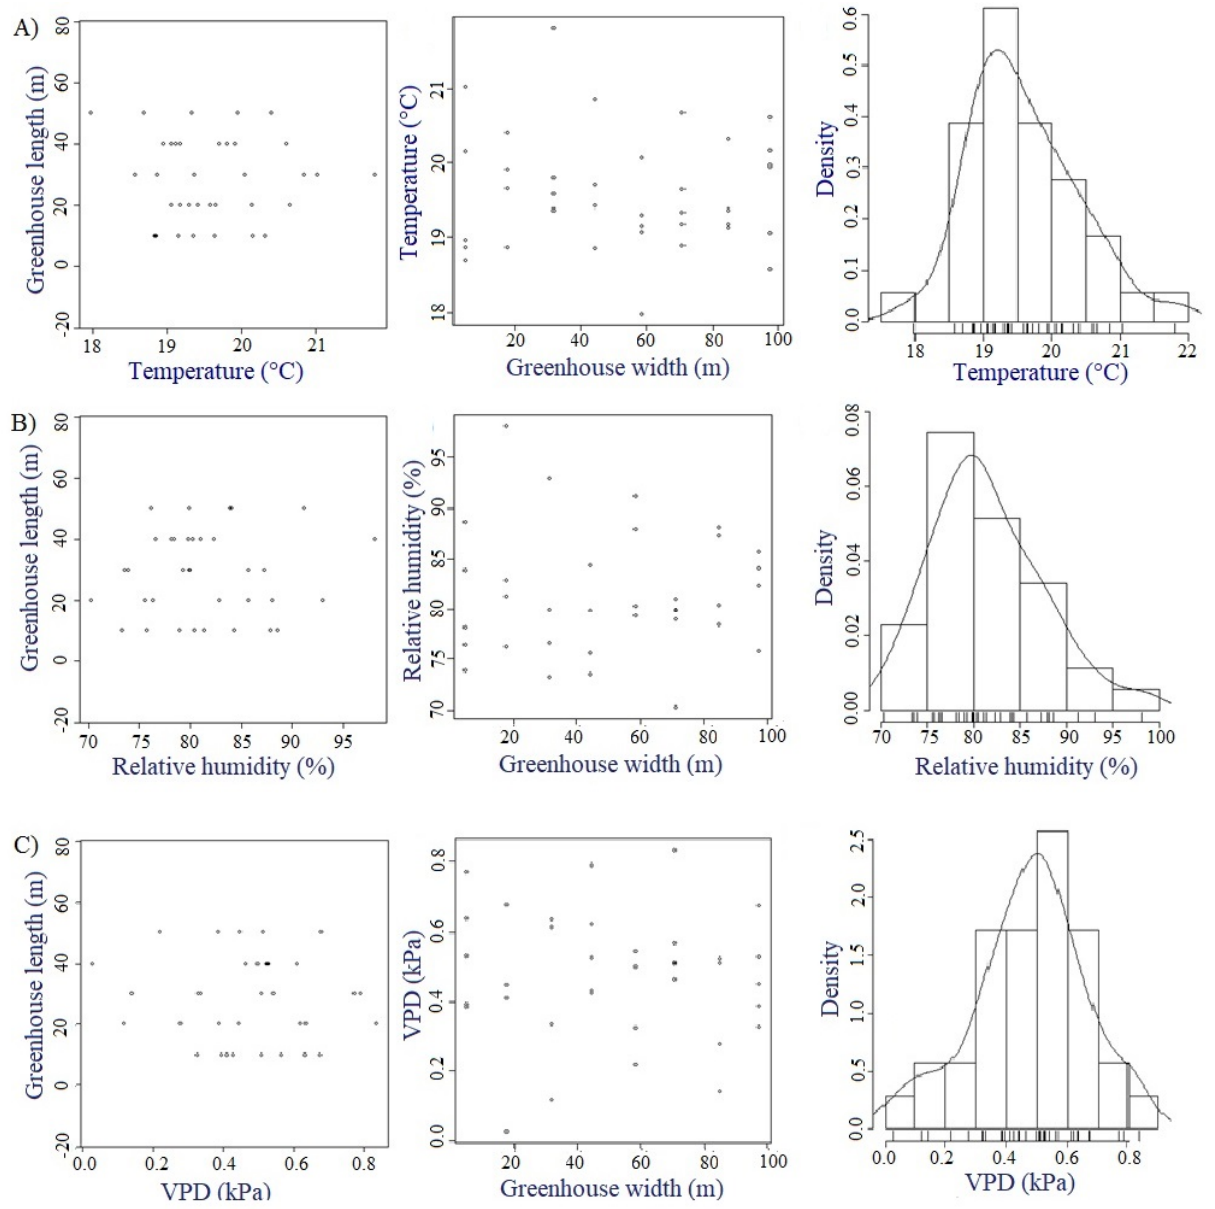
Figure 6. Results of exploratory spatial analysis, ( A ) Temperature in MG and ESRL 5, ( B ) Relative humidity in MG and ESRL 3 and ( C ) VPD in MG and ESRL 4.